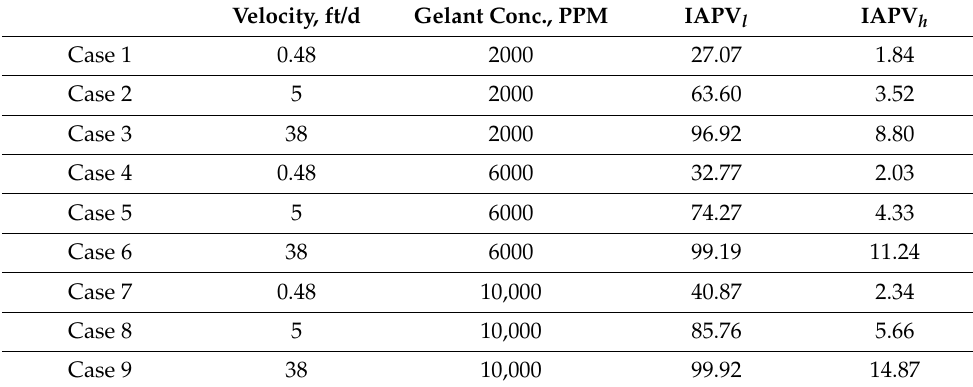
Table 3. Gelant placement cases setup.